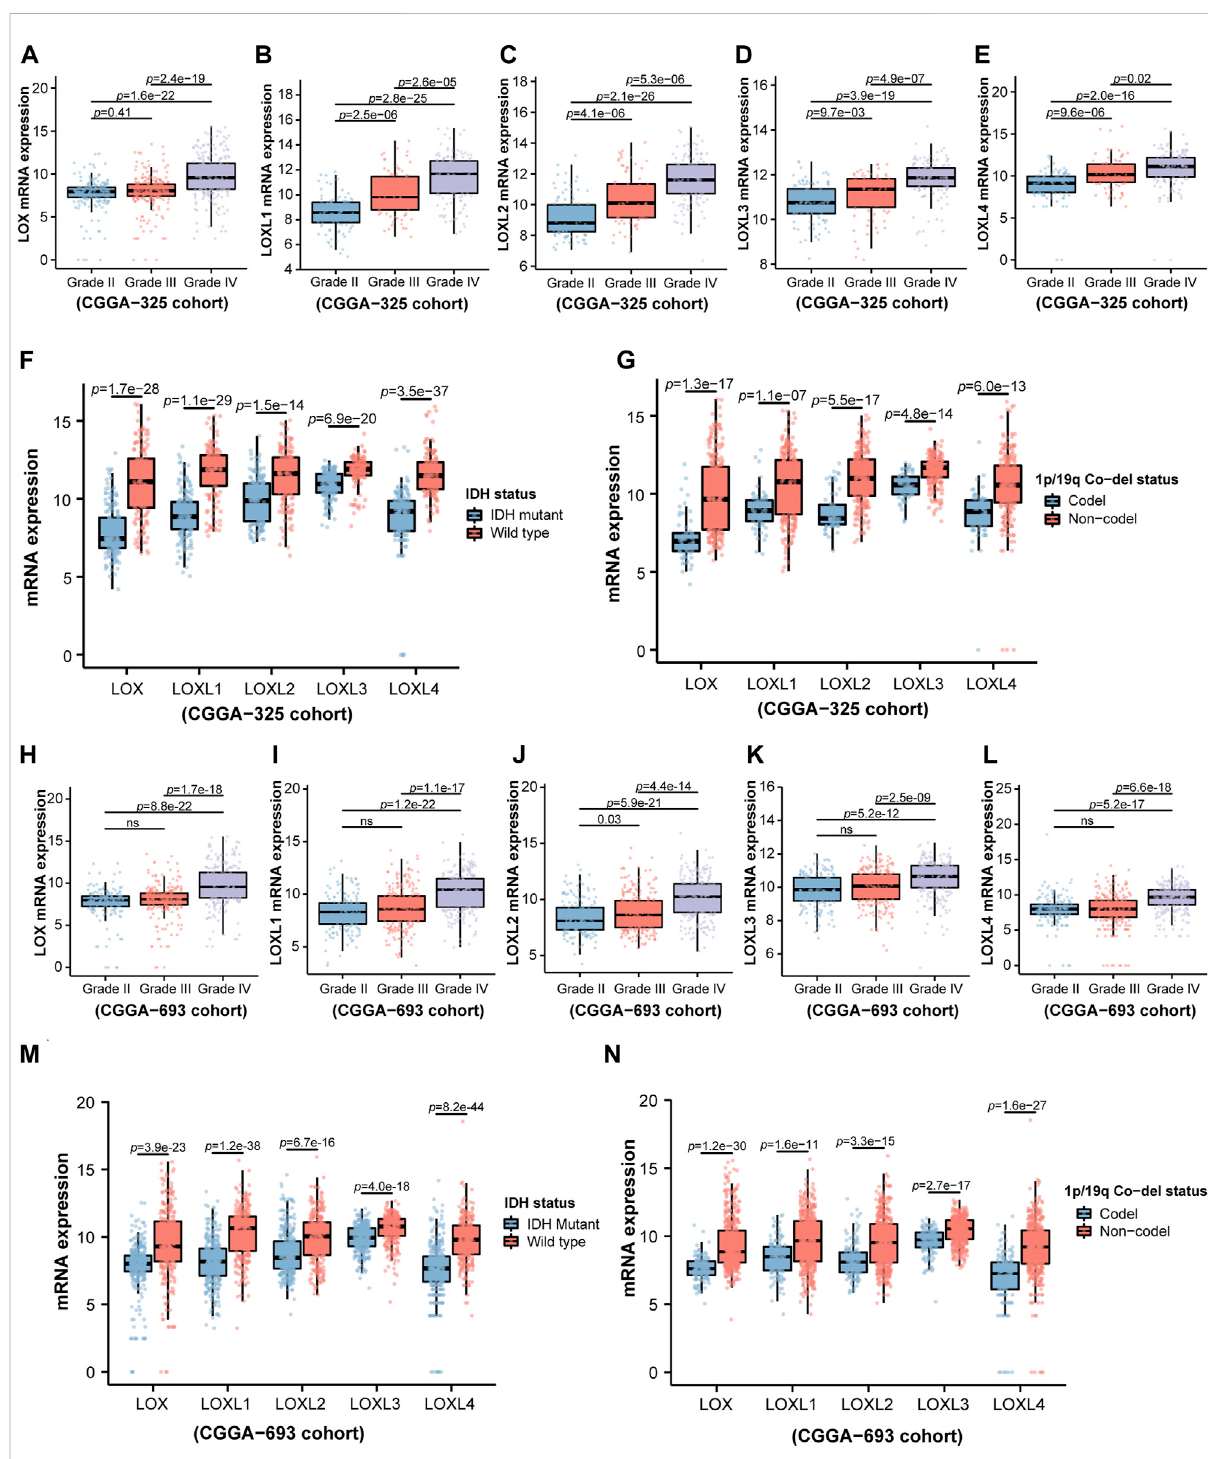
FIGURE 2 Analysis of relationship between LOXs expressions and WHO grade, IDH mutation status or 1p/19q co-deletion status in glioma in CGGA-325 and CGGA-693 cohorts. (A – E) Indicates mRNA expression levels of LOXs including LOX and LOXL1-4 in different glioma grades according to WHO in CGGA-325; (F) mRNA expressions of LOXs in IDH-mutation and wild type groups in CGGA-325; (G) mRNA expressions of LOXs in 1p/19q co- deletion and 1p/19q non-co-deletion groups in CGGA-325; (H – L) validation of the mRNA expression levels of LOXs in different glioma grades according to WHO in CGGA-693; (M) validation of mRNA expressions of LOXs in IDH-mutation and wildtypegroups in CGGA-693; (N) validation of mRNA expressions of LOXs in 1p/19q co-deletion and 1p/19q non-co-deletion groups in